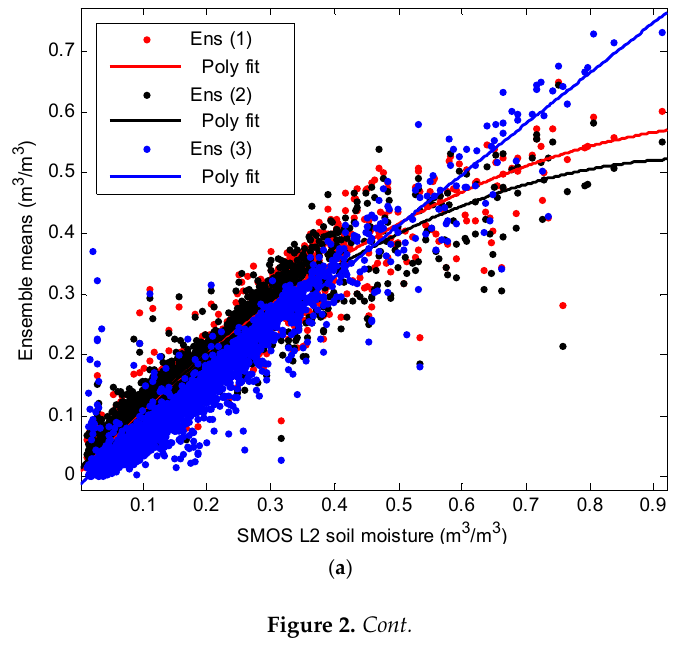
Figure 2. Cont. Figure 2.